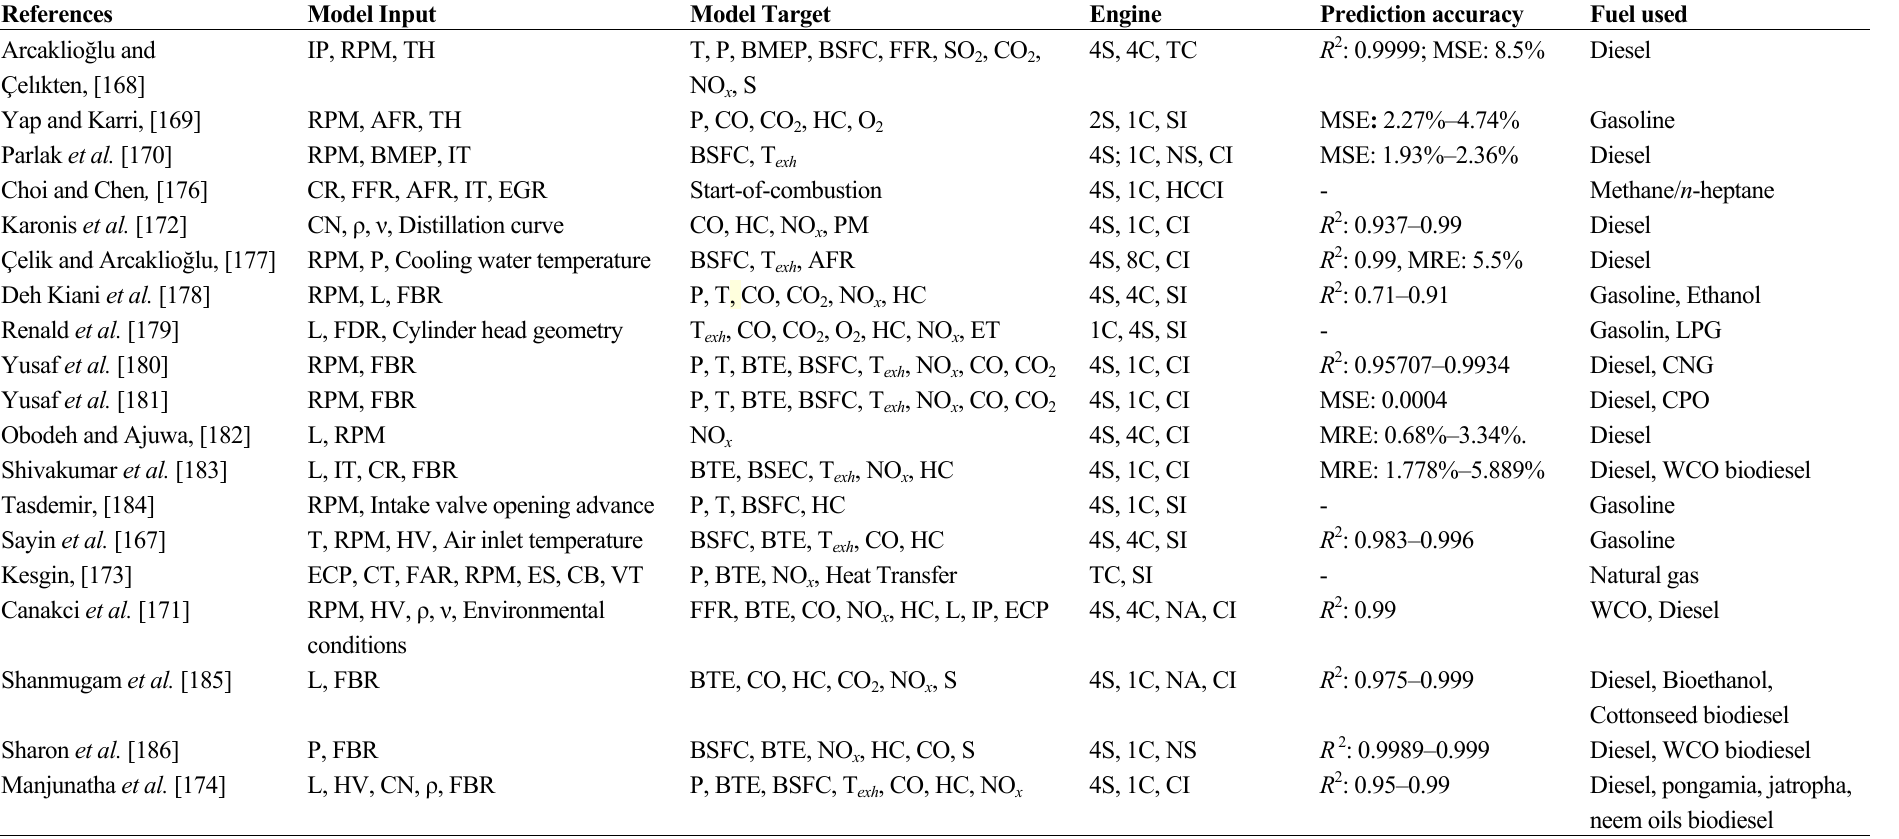
Table 7. ANN used in automobile engine